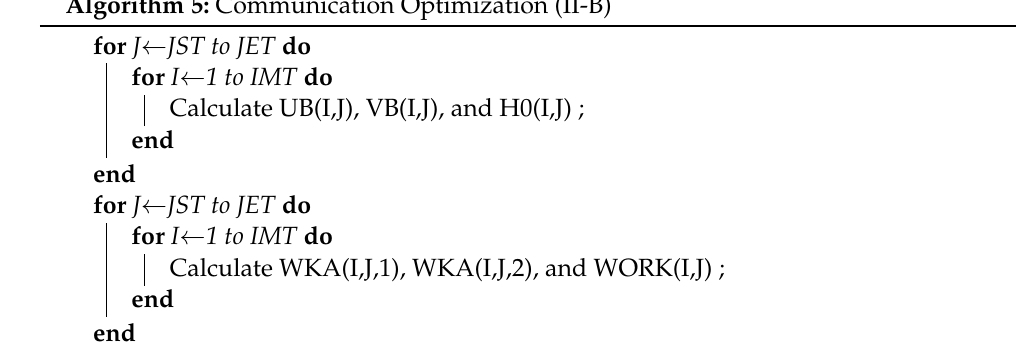
Algorithm 5: Communication Optimization